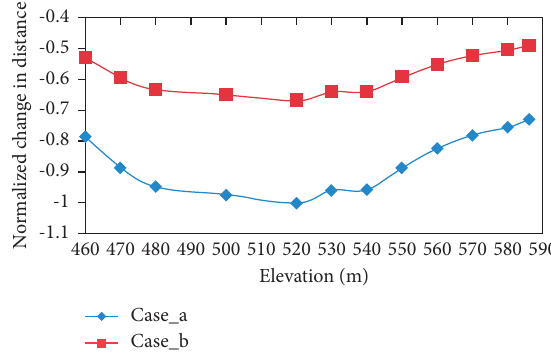
Figure 12: Normalized change in distance calculated from sim- ulated results.